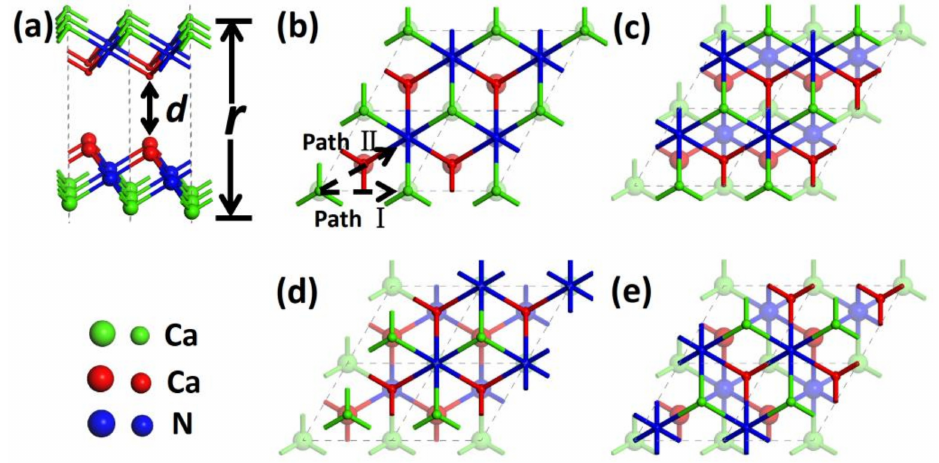
Figure 1. Sliding model. ( a , b ) Side and top views of the initial configuration, where r and d represent the interlayer distance and interfacial space, respectively. As all interfacial Ca atoms from two layers face each other, the configuration was defined as top stacking. The black dotted arrow shows the sliding path of the upper film. ( c , e ) Final configurations of the two paths, defined as bridge stackings. ( d ) Another high-symmetric configuration on sliding path II, defined as hollow stacking. The sliding process was modeled by moving the upper layer from the top to the bridge stackings in seven steps with the step lengths of 0.297 and 0.515 Å for paths I and II, respectively. To clearly exhibit the stacking characters, the atoms in different layers are labeled with different